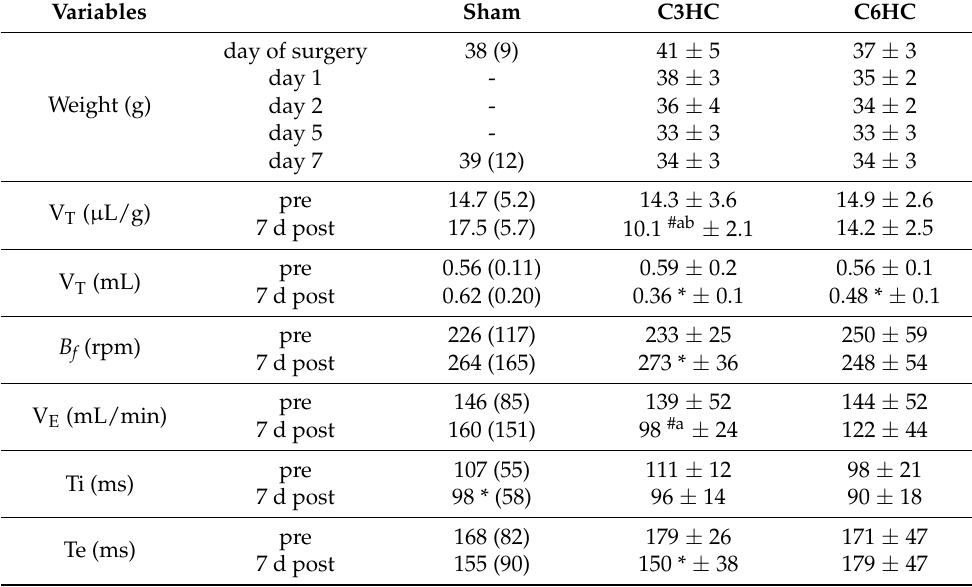
Table 1. Respiratory variables following C3 or C6